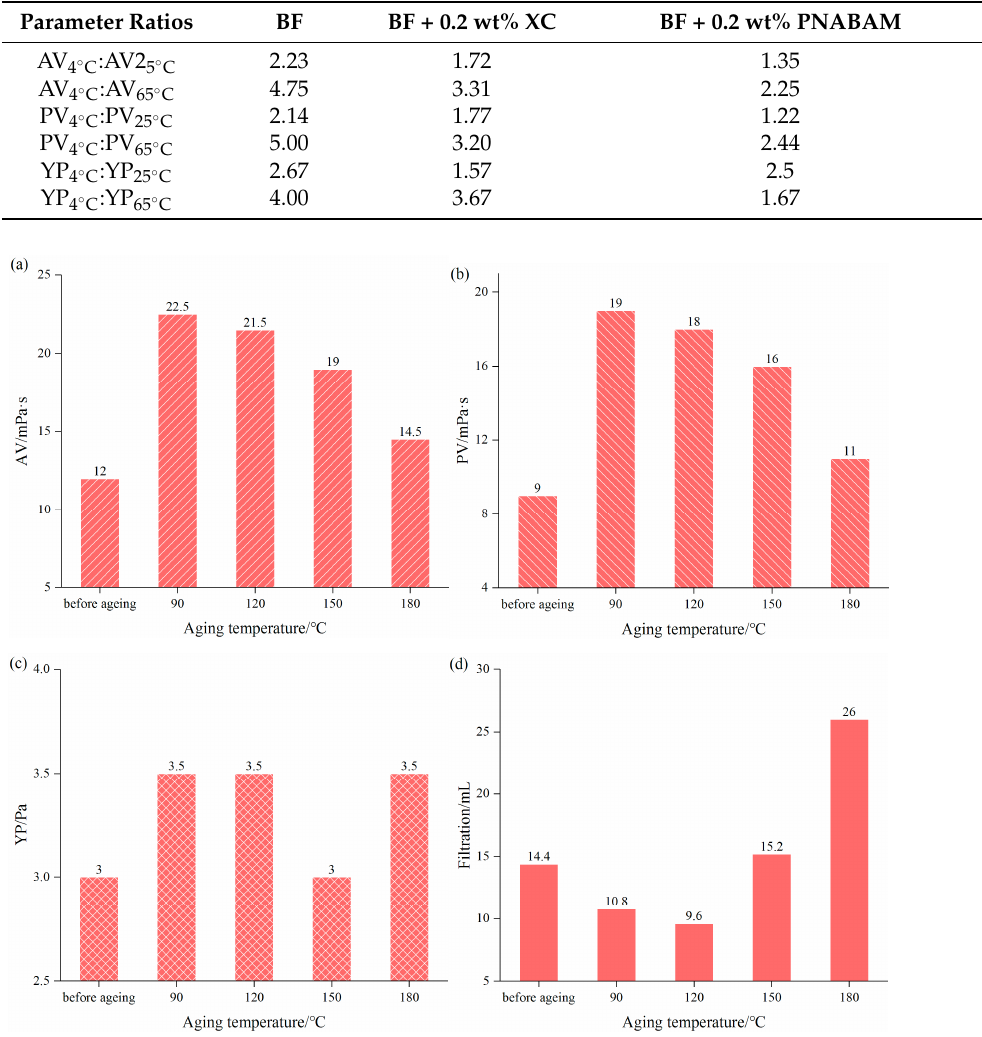
Table 1. Parameter ratios of different BFs.